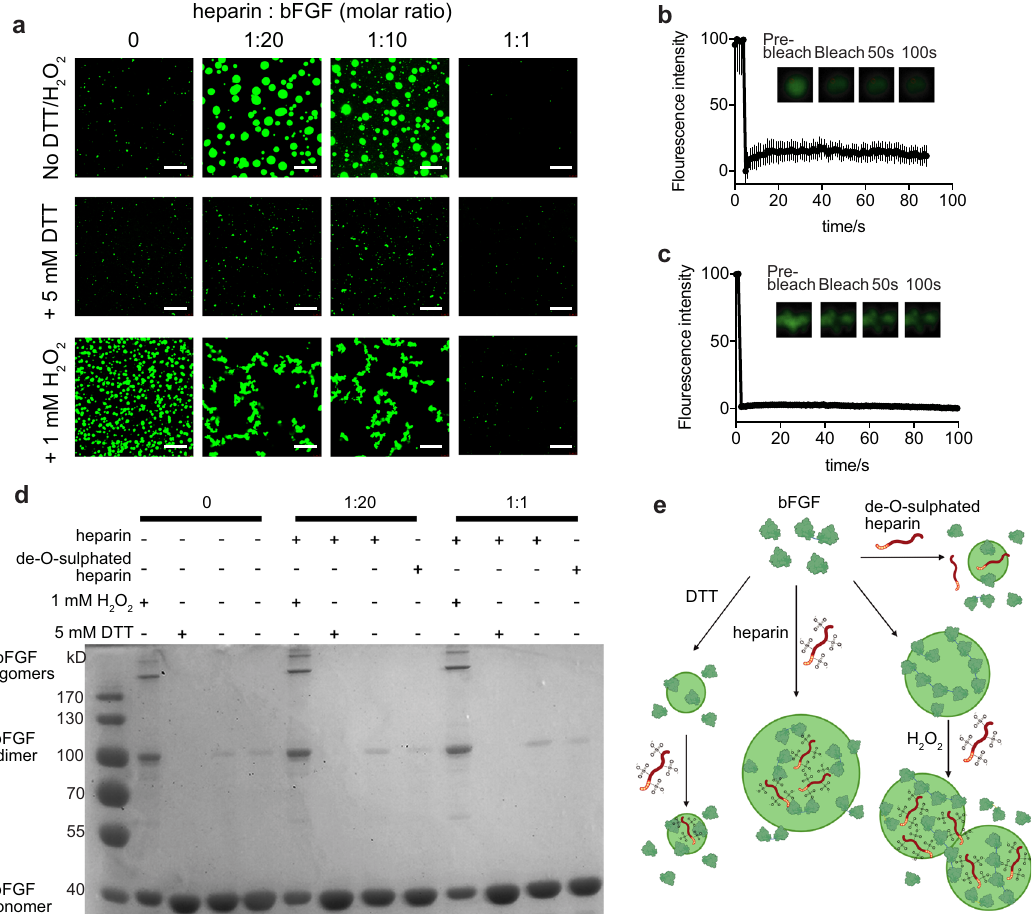
Fig. 2 Interaction of bFGF and heparin. a Confocal microscopy images of bFGF condensates with various ratios of heparin with 5 mM DTT or 1 mM H 2 O 2 . Scale bar = 5 µ m. b FRAP of the condensates formed by eGFP-bFGF oxidised in the presence of 1 mM peroxide. n = 3 biologically independent samples, data are presented as mean values± SEM. c FRAP of the condensates formed by oxidised eGFP-bFGF: heparin = 1:20. n = 4 biologically independent samples, data are presented as mean values± SEM. d Non-reduced SDS-PAGE of the eGFP-bFGF with different oxidative conditions and heparin concentrations, showing its assembling status. e Schematic illustration of the proposed mechanism of bFGF assembling under different oxidative status with heparin/ de-O-sulphated